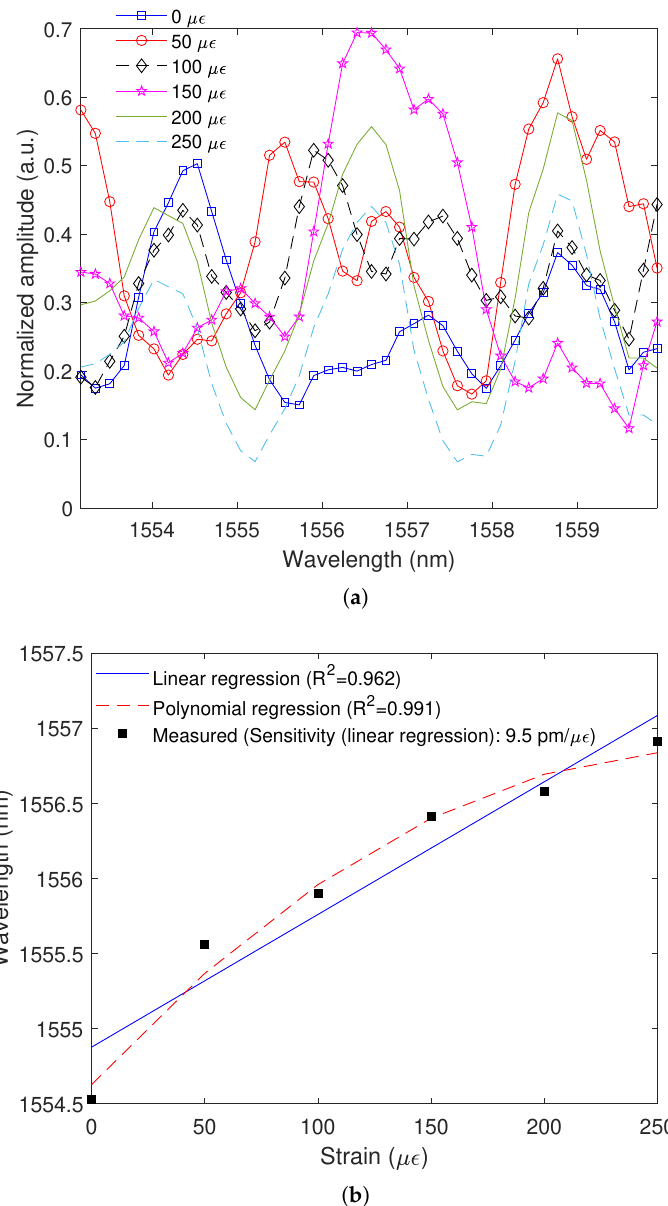
Figure 9. ( a ) Transmitted spectra as a function of the strain; ( b ) Wavelength variation as a function of strain for linear and polynomial